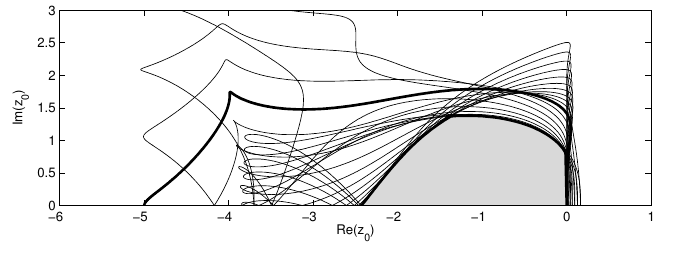
Figure 6. Stability regions S π/ 2 ,y , y = − 2 . 0 , 1 . 8 ,..., 2 . 0 (thin lines), S π/ 2 (shaded region), and S E (thick line) for β 10 = 3 . 088176567590889, β 20 = 3 . 144648727948133, β 30 = 4 . 411911013354342, β 21 = 0 . 727840859205079, β 31 = 0 . 837957009491469 and